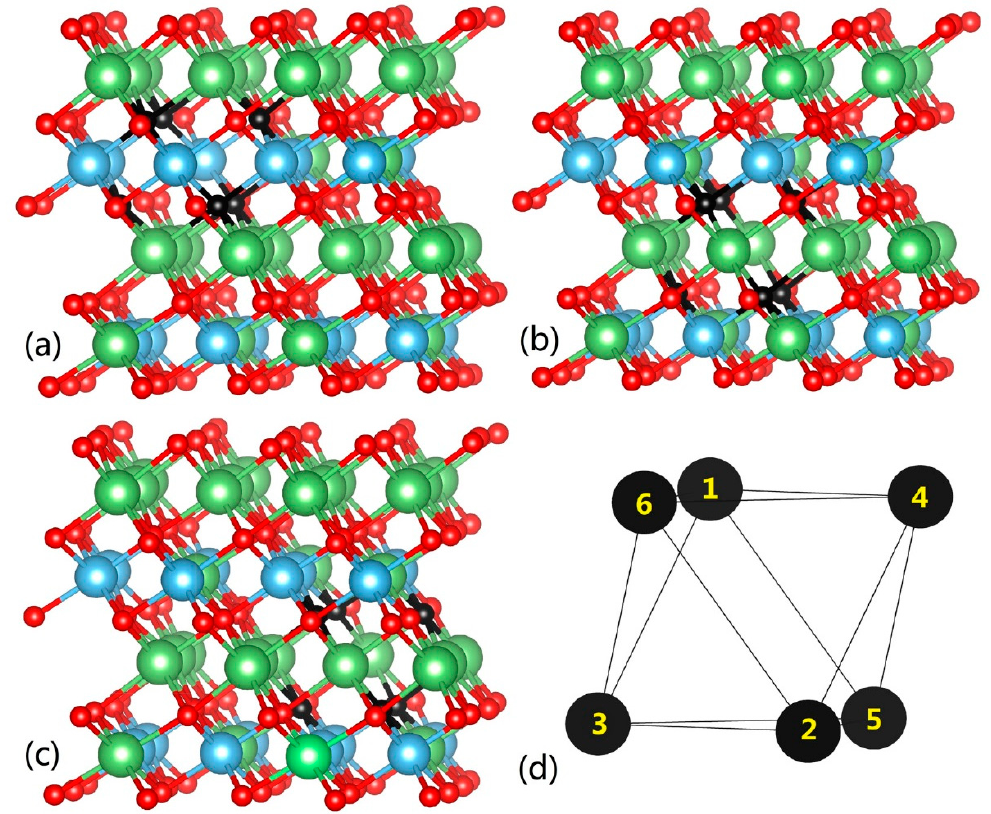
Figure 2. The defect model of Li 2 TiO 3 with three types of Li vacancies (color online). ( a ) Type A, ( b ) Type B, ( c ) Type C, and ( d ) sketch map of the octahedron configuration of each type vacancy. The black balls represent oxygen atoms.